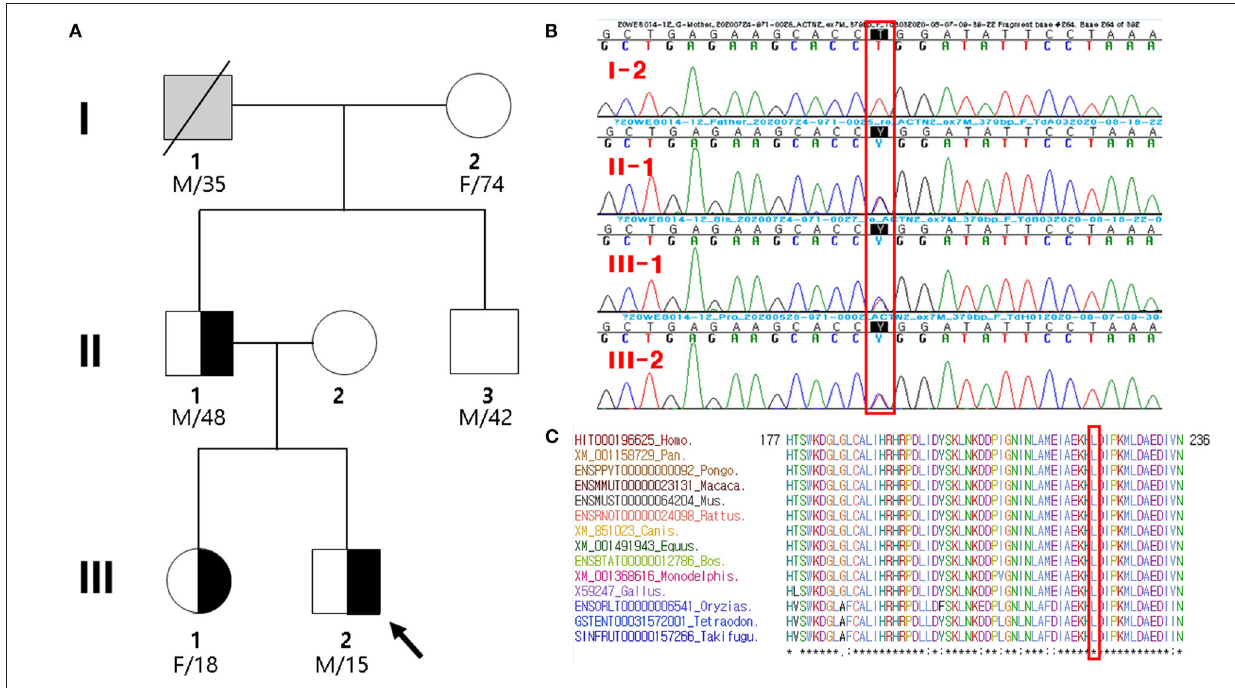
FIGURE 1 | Pedigree analysis and sequencing results. (A) Pedigree of the proband (arrow) and his family members with heterozygous ACTN2 variant. Gray symbol indicates that the presence of ACTN2 variant was not determined. (B) Sanger sequencing confirmed a novel missense mutation (c.668T > C; p.Leu223Pro) in ACTN2, which was of paternal origin. It is highlighted in the red box. (C) Sequence alignment of the conserved cytoplasmic domain of the ACTN2 protein in multiple vertebrate species. Protein sequence of the Leu223Pro residue is highly conserved across the compared species. It is highlighted in the red